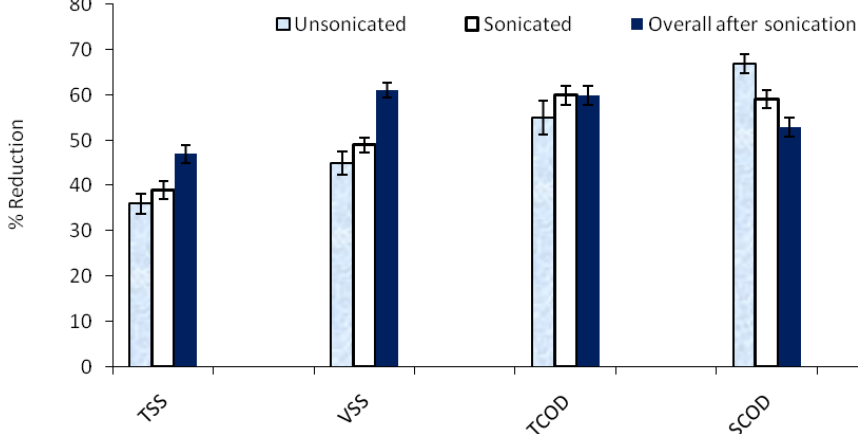
Figure 1. Degradation efficiency of unsonicated and sonicated